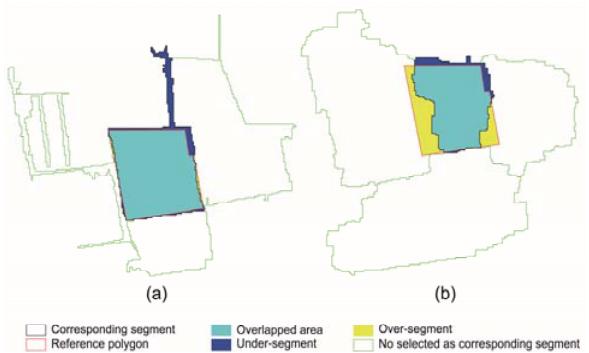
Figure 3. Illustration of geometric discrepancies between reference polygons and candidate/corresponding segments on a reference greenhouse from R1.